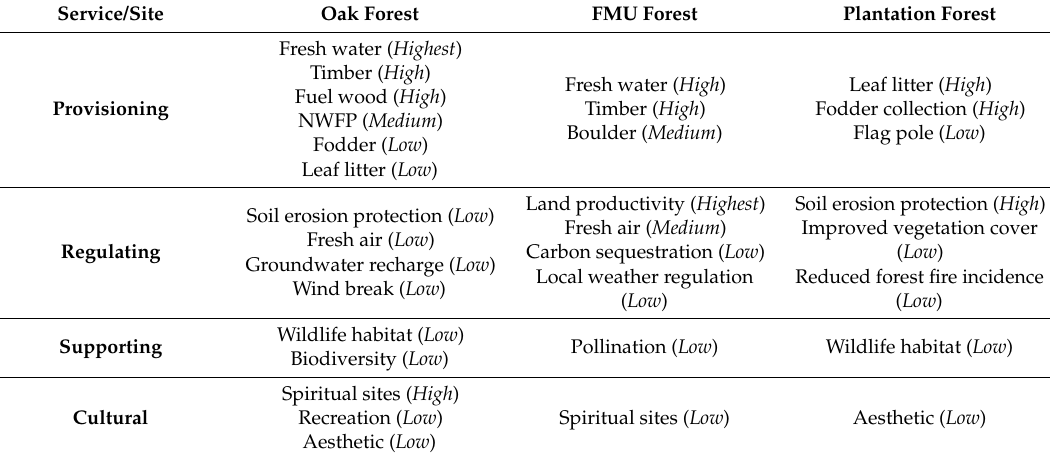
Table 1. Priority ecosystem services derived from forests indicated by villagers in focus group discussions in the three study sites in Bhutan. Ranking is according to the prioritization within focus groups and the frequency of mention by focus groups ( high indicates mention by all or a marjority of groups; low is one or